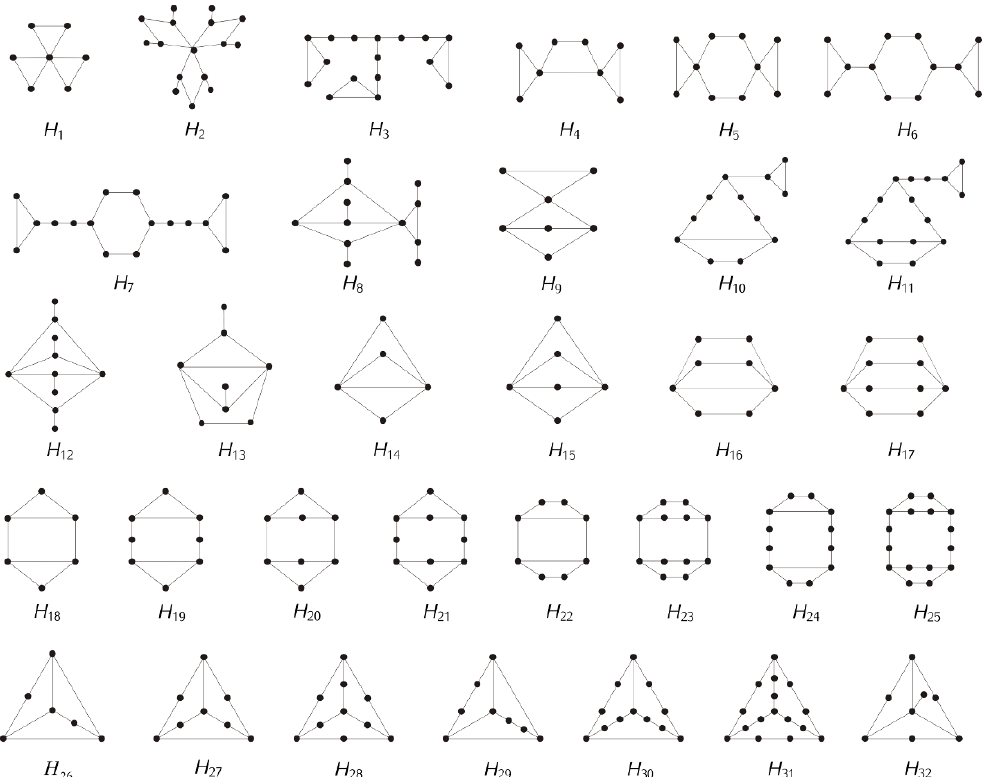
Figure 3. Graphs H